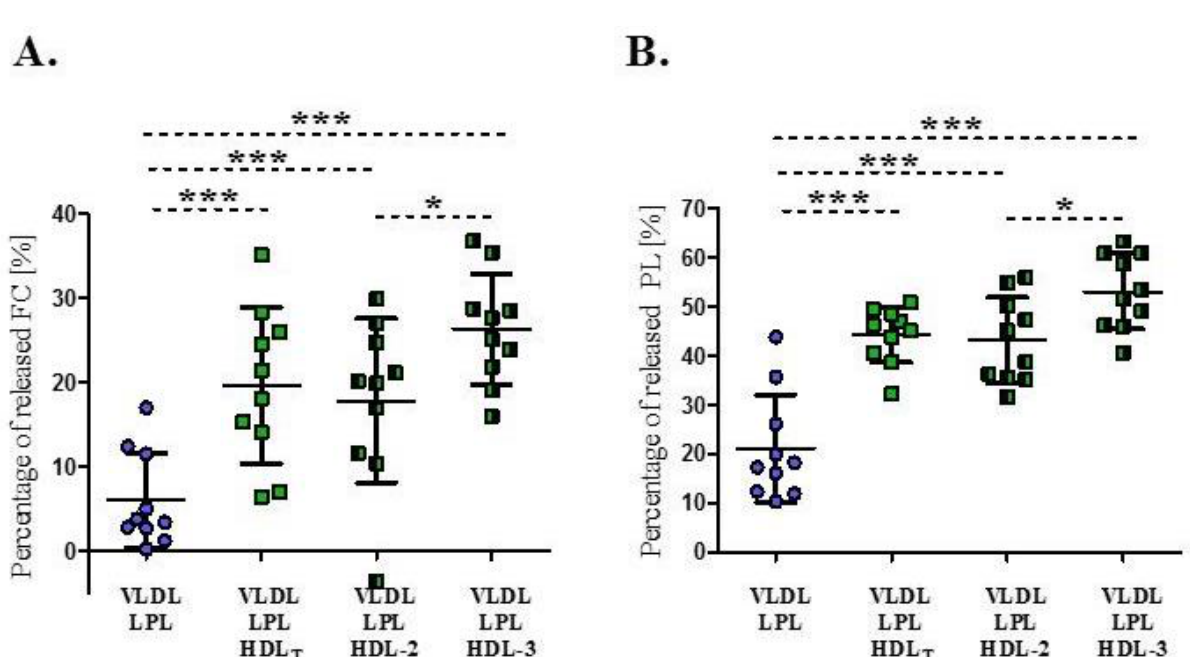
Figure 2. Percentage of free cholesterol ( A ) and phospholipids ( B ) released from VLDL during LPL-mediated lipolysis in the absence or presence of HDL T and HDL subpopulations: HDL-2 and HDL-3. Data are presented as mean ± SD, n = 10, * p < 0.05; *** p < 0.001. Data were analysed by Repeated Measures ANOVA with Tukey post hoc.